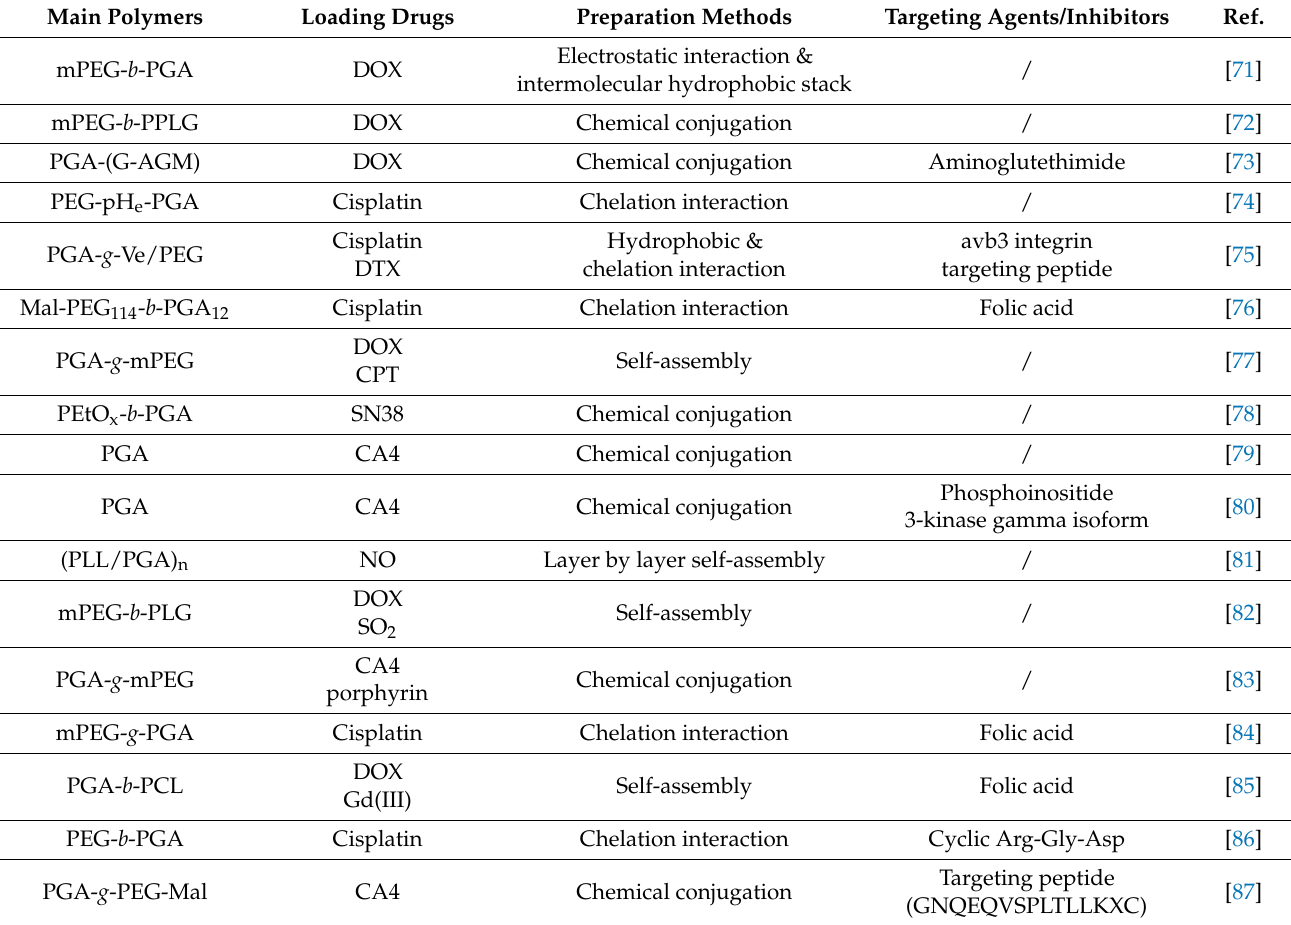
Table 1. Summary of PGA-based nanocarriers with unique